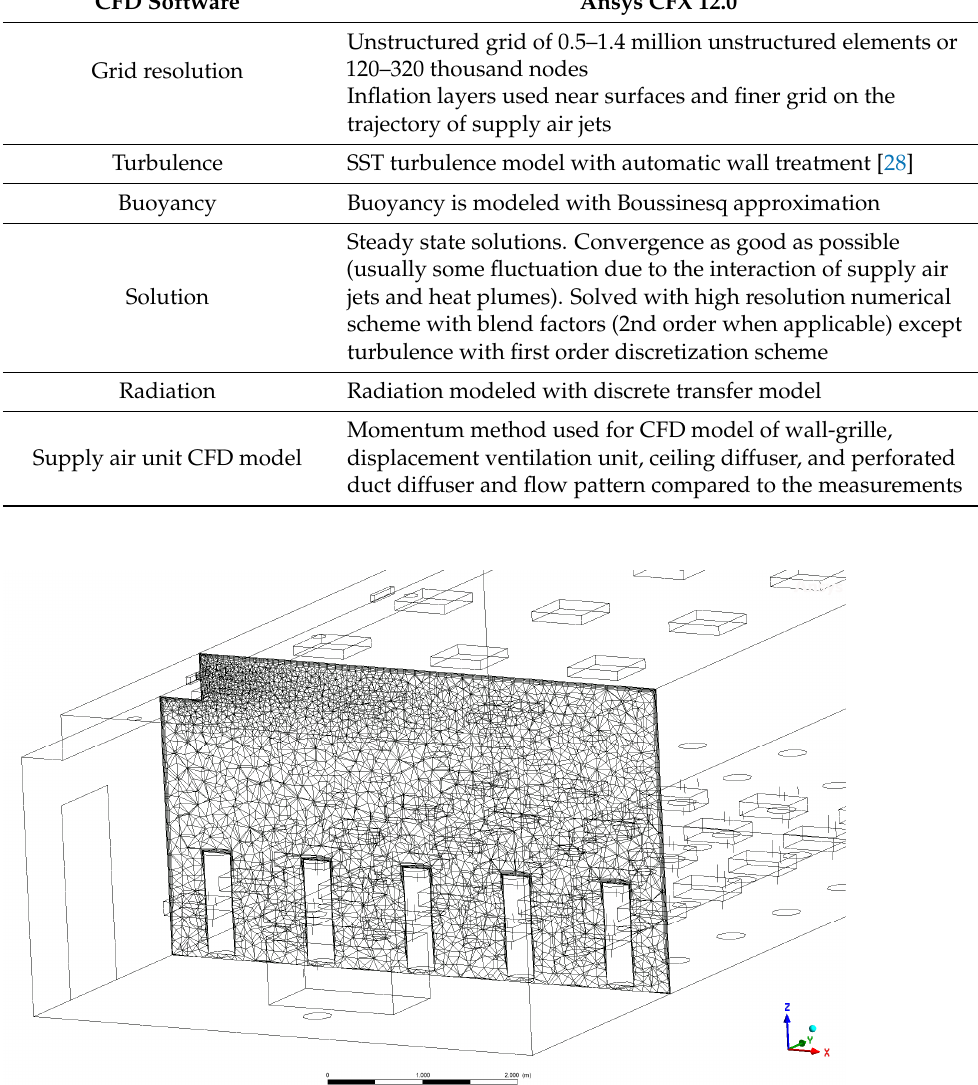
Figure 4. Set ‐ up of the whole classroom by CFD simulation in ( a ) winter case (16 people) and ( b ) summer case (31 people). The supplied airflow rate was 180 L/s (3.0 L/s/m 2 ) in both summer and winter. Heat balance in the simulated cases is described in Table 2. The selected cases present the max ‐ imum and minimum cooling loads. The maximum cooling represents the fully occupied classroom in the summer conditions. The minimum cooling represents the half ‐ occupied classroom in the winter conditions. This describes the possible range of the cooling load with the different number of pupils in the lecture. In summer conditions, there are 31 people in the classroom and the surface temperature of the window is 30 °C. The maxi ‐ mum effect of the heat gains from solar load and occupants was investigated with differ ‐ ent air distribution methods. In winter conditions, there are 16 people in the classroom, and the surface temperature of the window is 11 °C. In addition, there is a 500 W radiator underneath the window in the winter conditions. Due to the heat balance in the winter, the number of occupants is 16 people. The minimum effect of the heat gain from occupants and heat loss from window were investigated. The design room air temperatures are 26 °C and 21 °C [29] in summer and winter conditions, respectively.